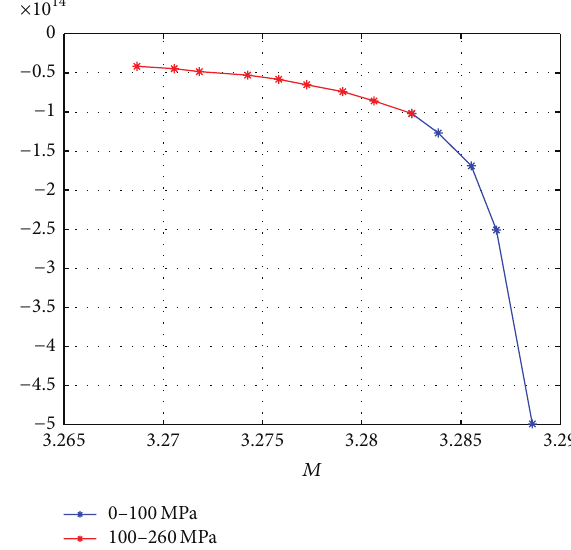
Figure 6: The fitting curve 𝑀 - 𝑏 of a 8.8 low-carbon steel bolt.